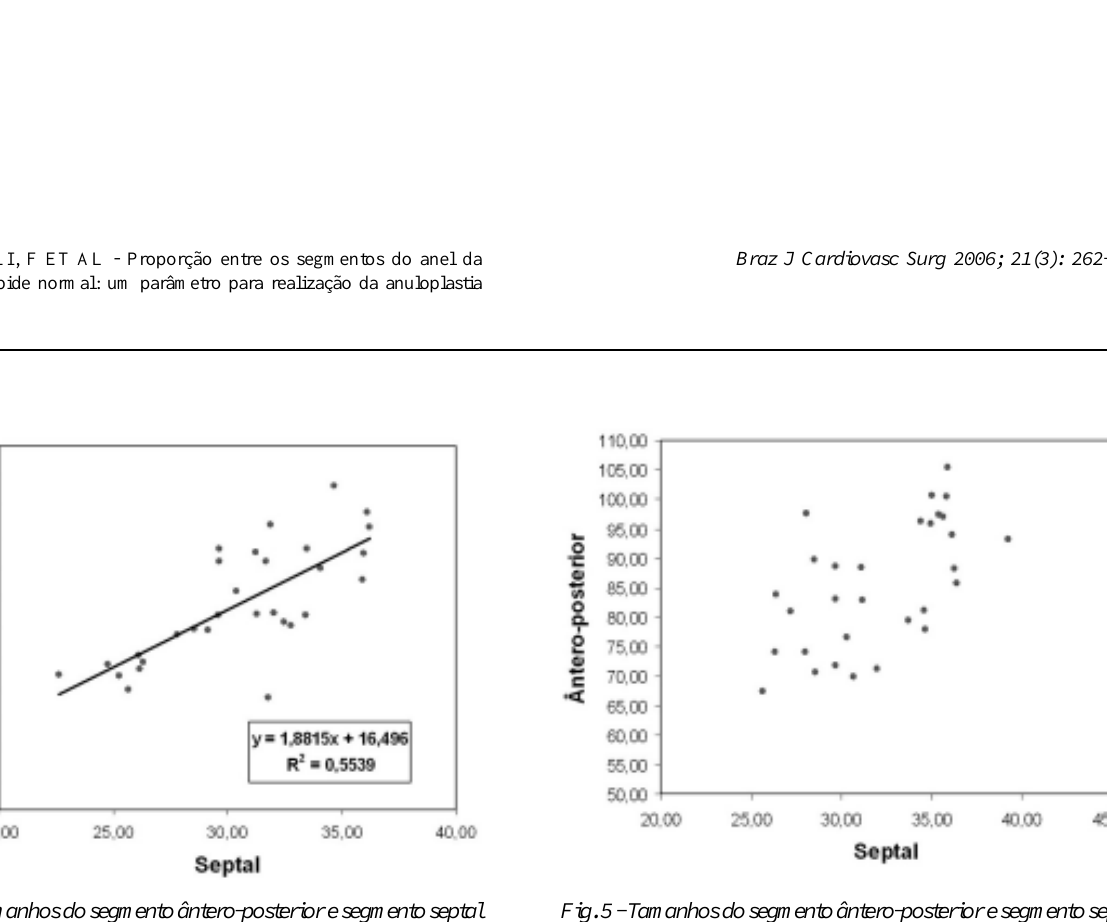
Fig. 4 - Tamanhos do segmento ântero-posterior e segmento septal no anel tricuspídeo íntegro (em milímetros)